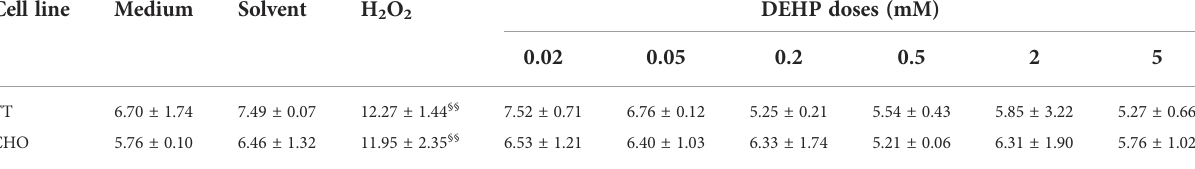
Data are presented as means ± SD of two independent experiments for each treatment. Signi fi cance of Student ’ s t -test (ts): §§ p ≤ 0.01 H 2 O 2 vs medium. TT, Tursiops truncatus ; CHO, Chinese hamster ovary; DEHP, di(2-ethylhexyl)phthalate.